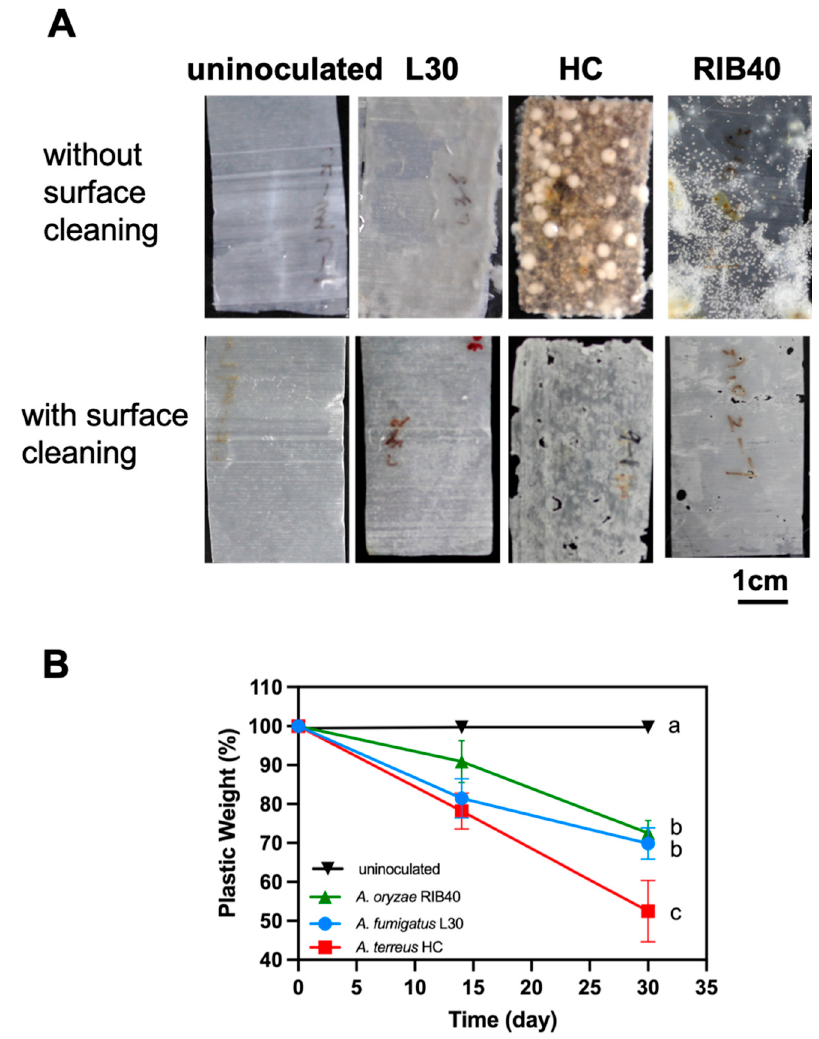
Figure 2. Colonization of fungal strains on PBSA plastic films and their degradation abilities. ( A ) Biodegradation PBSA films after 30 days of incubation. Twelve pieces of PBSA films (size: 2.5 × 5.0 cm 2 ; thickness: 50 µ m) were cocultured with A. terreus HC, A. fumigatus L30, and A. oryzae RIB40 (ATCC42149) at 30 °C in a carbon-free basal medium. The upper panel shows the attached hyphae of individual strains on the surface of PBSA plastic films after 30 days of incubation. The bottom panel shows the surface of plastic films after hyphae removal by rinsing with DDW. ( B ) Weight loss of PBSA plastic film against time. The sampling times were 0, 14, 30 days after incubation. The values are expressed as the mean ± standard deviation of three biological replicates ( p < 0.05; Tukey’s post hoc ANOVA test).